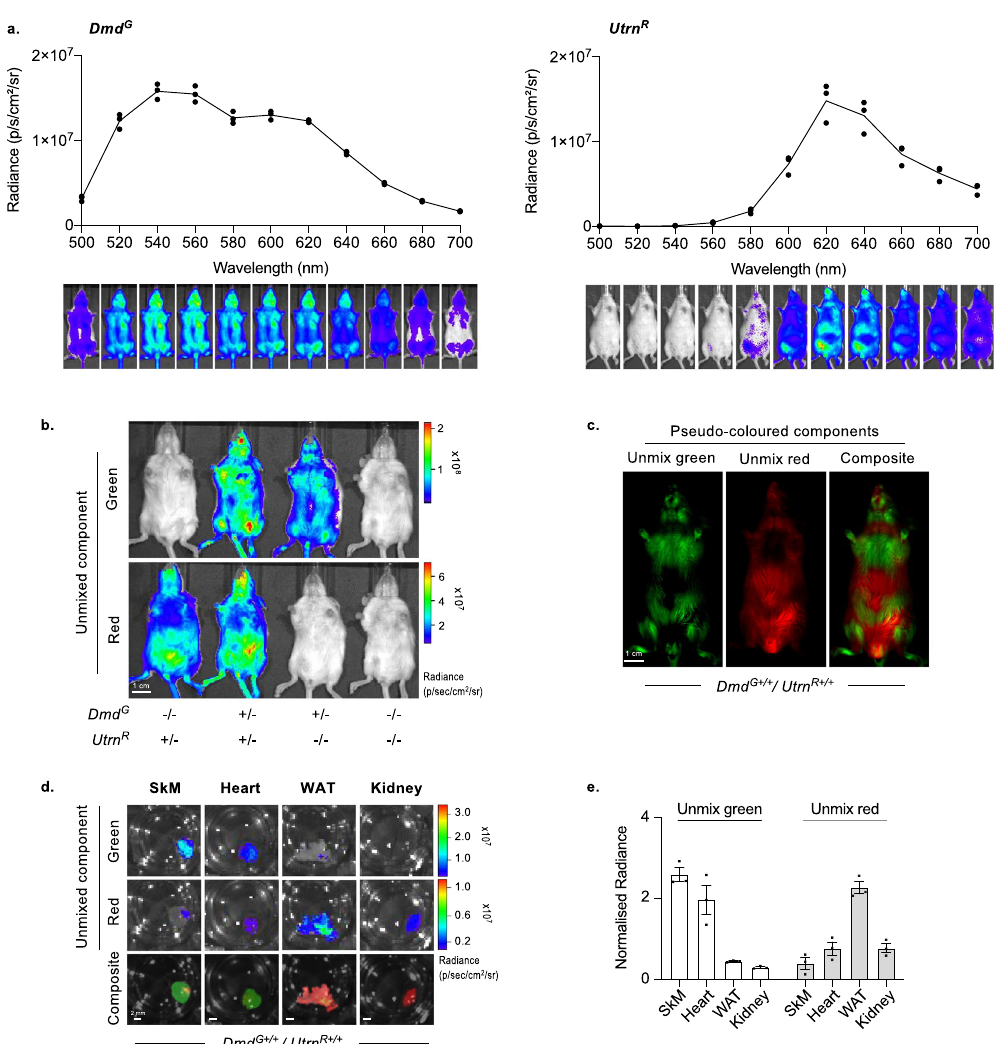
Fig. 2 Simultaneous visualisation of Dmd and Utrn in vivo using dual colour bioluminescence imaging. a Emission spectra were generated from single reporter mouse lines ( Dmd G + / − left; Utrn R + / − right). Bioluminescence images were taken using emission fi lters across 500 – 700 nm range with discrete 20 nm band pass fi lters. Graphs show mean whole-body radiance ( n = 3) emitted from adult female mice at each wavelength, with representative images below. The peak of Dmd G emission was at 540 nm, with a shoulder at 600 nm, while Utrn R peaked at 620 nm. These spectra were used as references for spectral unmixing analysis in b , c . b Spectral unmixing of Dmd G + / − , Utrn R + / − , Dmd G + / − / Utrn R + / − and WT adult siblings. Unmixing algorithms were able to distinguish bioluminescence emitted from CBG99Luc (green, upper panel) and RFluc (red, lower panel); the green component was visible only in Dmd G + / − and Dmd G + / − / Utrn R + / − and red only in Utrn R + / − and Dmd G + / − / Utrn R + / − animals. c Pseudo coloured images of spectral unmixing of an adult male dual homozygous ( Dmd G + / + / Utrn R + / + ) mouse. Green signal was detected in the skeletal muscle and head, as observed in Dmd G mice, and red was predominant in the abdomen, as observed in Utrn R mice. d , e Spectral unmixing of tissues dissected from Dmd G + / + / Utrn R + / + mice. The reference spectra used are shown in Fig. S2. Representative images ( d ) and quanti fi cation of the radiance emitted from each component ( e ). SkM and heart emitted green signal, corresponding to Dmd expression, while red signal was strongest in WAT, corresponding to Utrn expression. Bars show mean + / −